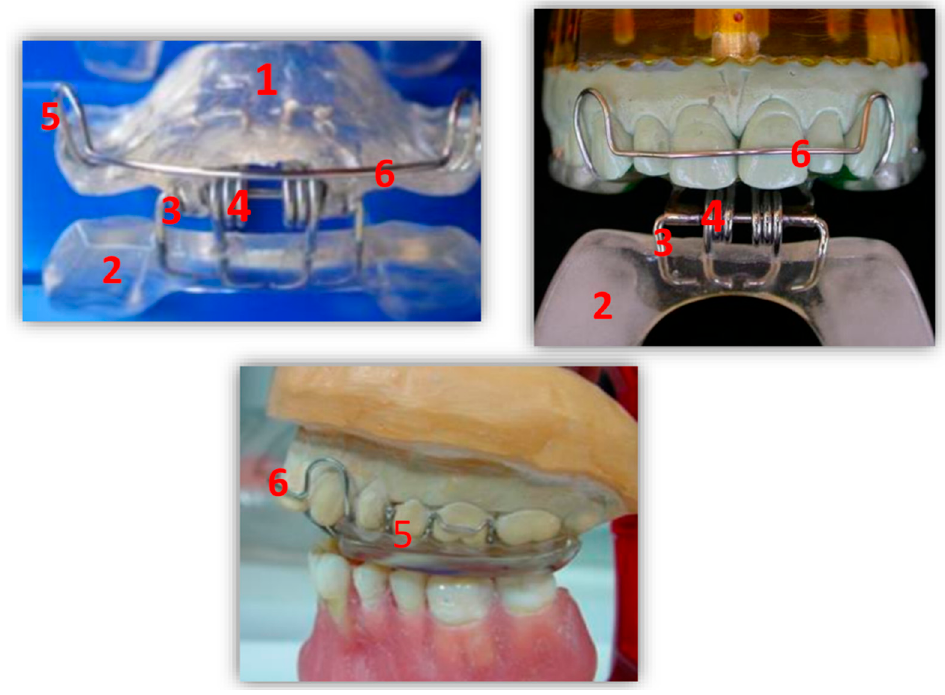
Figure 1. RA.DI.CA. splint and its components.